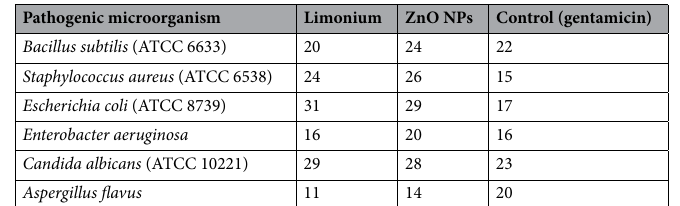
Table 3. Inhibition zones (diameter in mm) of phytosynthesized ZnO-NPs and L. pruinosum extract against different pathogenic microorganisms.